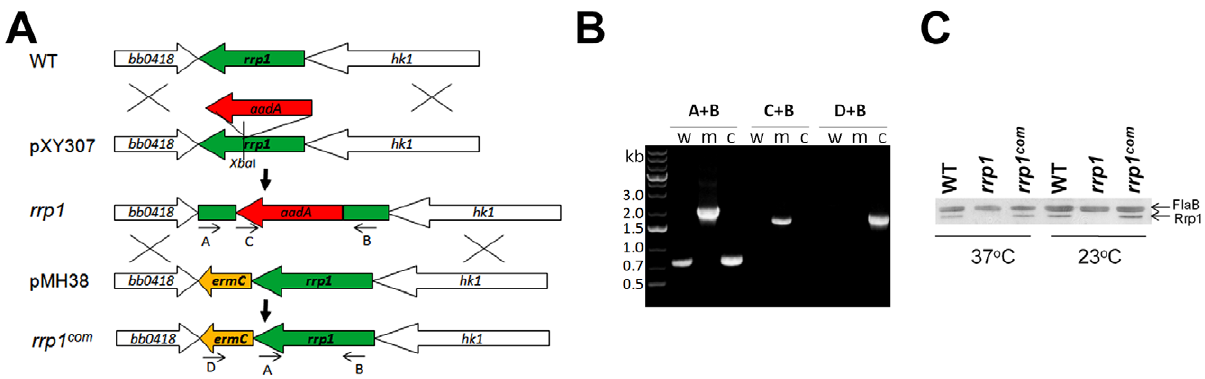
Figure 1. Construction of the rrp1 mutant and the repaired strain. ( A ) Strategy for construction of the rrp1 mutant and the repaired strain ( rrp1 com ). Arrows indicate the approximate positions of the oligonucleotide primers used for PCR analysis. ( B ) PCR analysis of strains. The specific primer pairs used in PCR are indicated above lanes. Lane W, wild-type (5A4NP1); lane M, the rrp1 mutant; lane C, rrp1 com . ( C ) Western blot analysis of whole-cell lysates of WT, rrp1 , and rrp1 com spirochetes probed with a -Rrp1 and a -FlaB monoclonal antibodies.